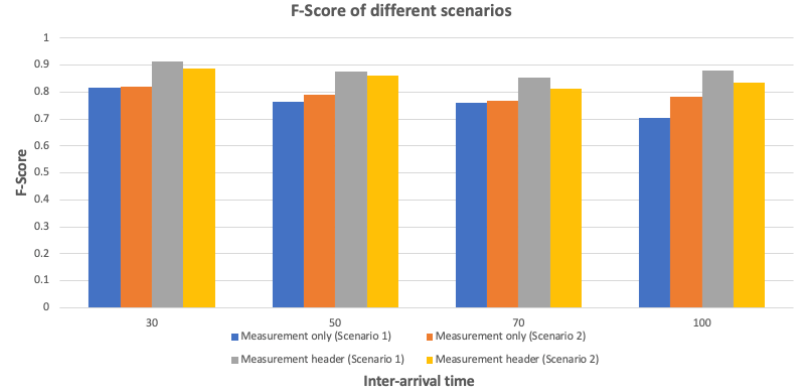
Figure 11. F-Score results for the prototype implemented in real